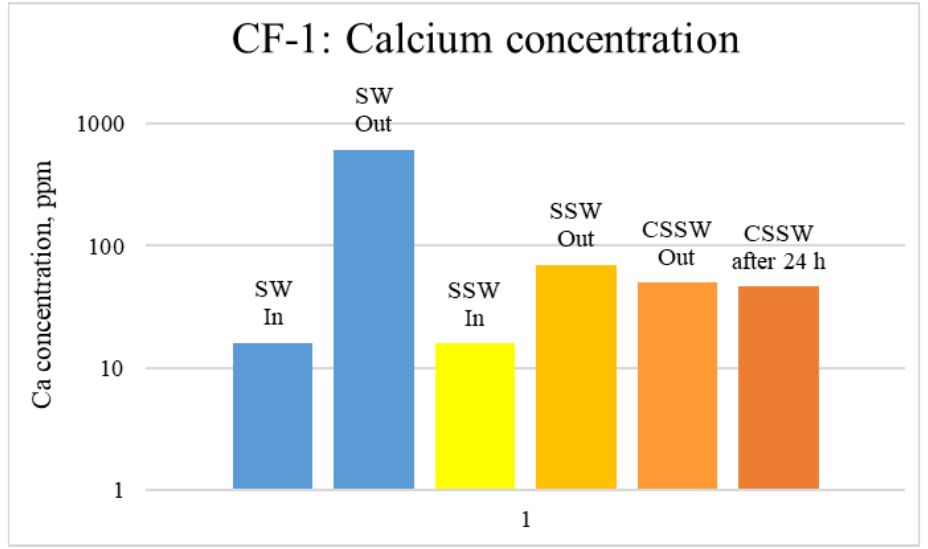
Figure 12. ICP analysis of CF1 brines: Calcium concentration.